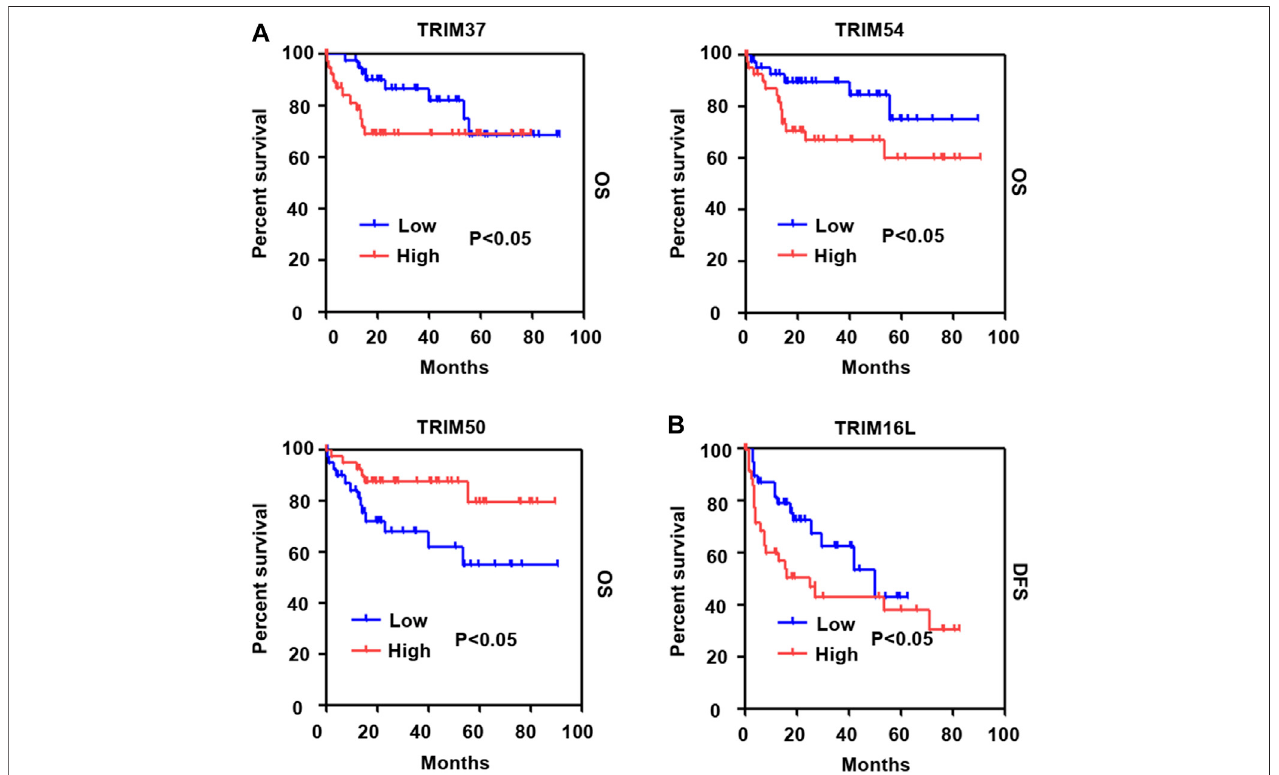
FIGURE7| TheassociationofTRIMgeneswiththesurvivalin HBV-associated HCCbasedon theKaplan-Meieranalysiswiththe Genhan-Breslow-Wilcoxon test. (A) The relationships of TRIM37, TRIM50, and TRIM54 with OS of HBV-positive HCC patients. (B) The relationships of TRIM16L with DFS in HBV-associated HCC.